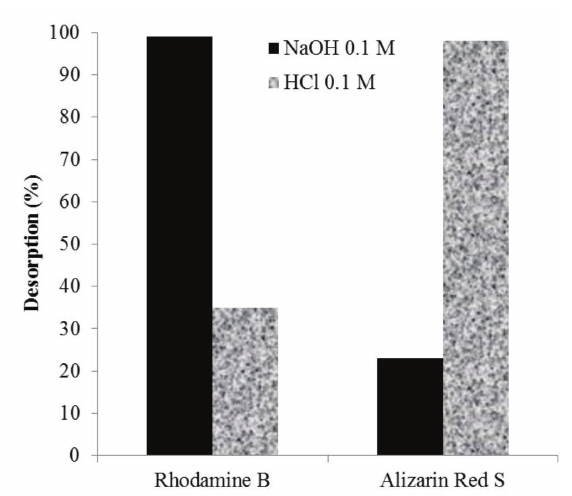
Fig. 13 – Desorption study of Rhodamine B and Alizarin Red S onto CES adsorbent